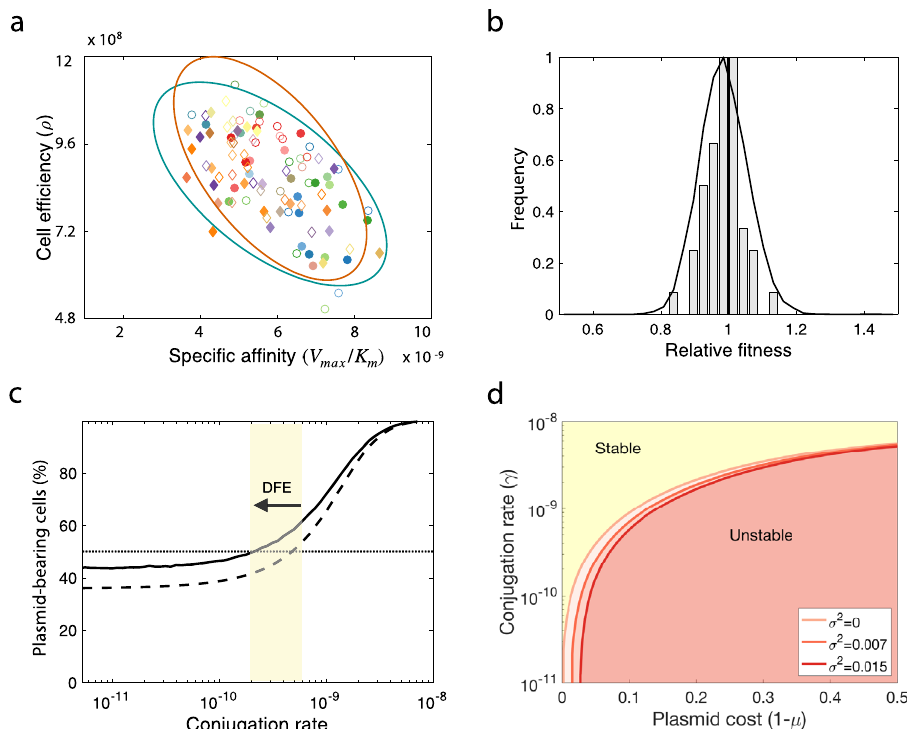
Fig. 5 Modelling pOXA-48 fi tness effects. a Distribution of parameter values obtained using Bayesian inference to estimate growth kinetic parameters from OD measurements obtained for each strain in isolation. Diamonds represent Klebsiella spp. strains and circles E. coli clones; fi lled symbols denote plasmid-bearing strains and empty symbols plasmid-free cells. The ellipses represent standard deviations of best- fi t normal distributions (green for plasmid-bearing strains and orange for plasmid-free cells). b Bars represent a distribution of plasmid fi tness effects obtained from in silico competition experiments with parameter values determined from experimental growth curves. The solid curve represents the computationally estimated distribution obtained by randomly sampling wild-type and transconjugant parameter distributions obtained using the MCMC algorithm and numerically solving the model to evaluate the relative fi tness associated with plasmid carriage. c Fraction of plasmid-bearing cells (after competing against plasmid-free cells) as a function of the rate of horizontal transfer for random plasmid – host associations sampled from the MCMC parameter distribution. The dotted line illustrates the mean of 10 4 pair-wise competition experiments under the assumption that plasmid-bearing is associated with a constant reduction in fi tness in different clones ( w = 0.985, var = 0), while the solid line is obtained by considering a wide variability of fi tness effects ( w = 0.985, var = 0.0070). The arrow denotes the difference in the conjugation threshold that positively selects for plasmids in the population, supporting the tenet that the variability of fi tness effects maintains plasmids in the population at lower conjugation rates. d Stability of plasmids as a function of plasmid cost and conjugation rate. Yellow area corresponds to the range of conjugation rates and plasmid costs that positively selects for the plasmid in the population, while red denotes the plasmid is unstable. Solid lines illustrate the critical conjugation rate estimated numerically after performing 10 3 pair-wise competition experiments under the assumption that plasmid-bearing is associated with different levels of variability of fi tness effects (see legend). Note that the increase in plasmid stability associated with the variability of fi tness effects is more relevant for plasmids producing low average fi tness cost, and becomes negligible for plasmids producing large average fi tness cost, which depend more dramatically on a high conjugation rate. Source data are provided as a Source data fi